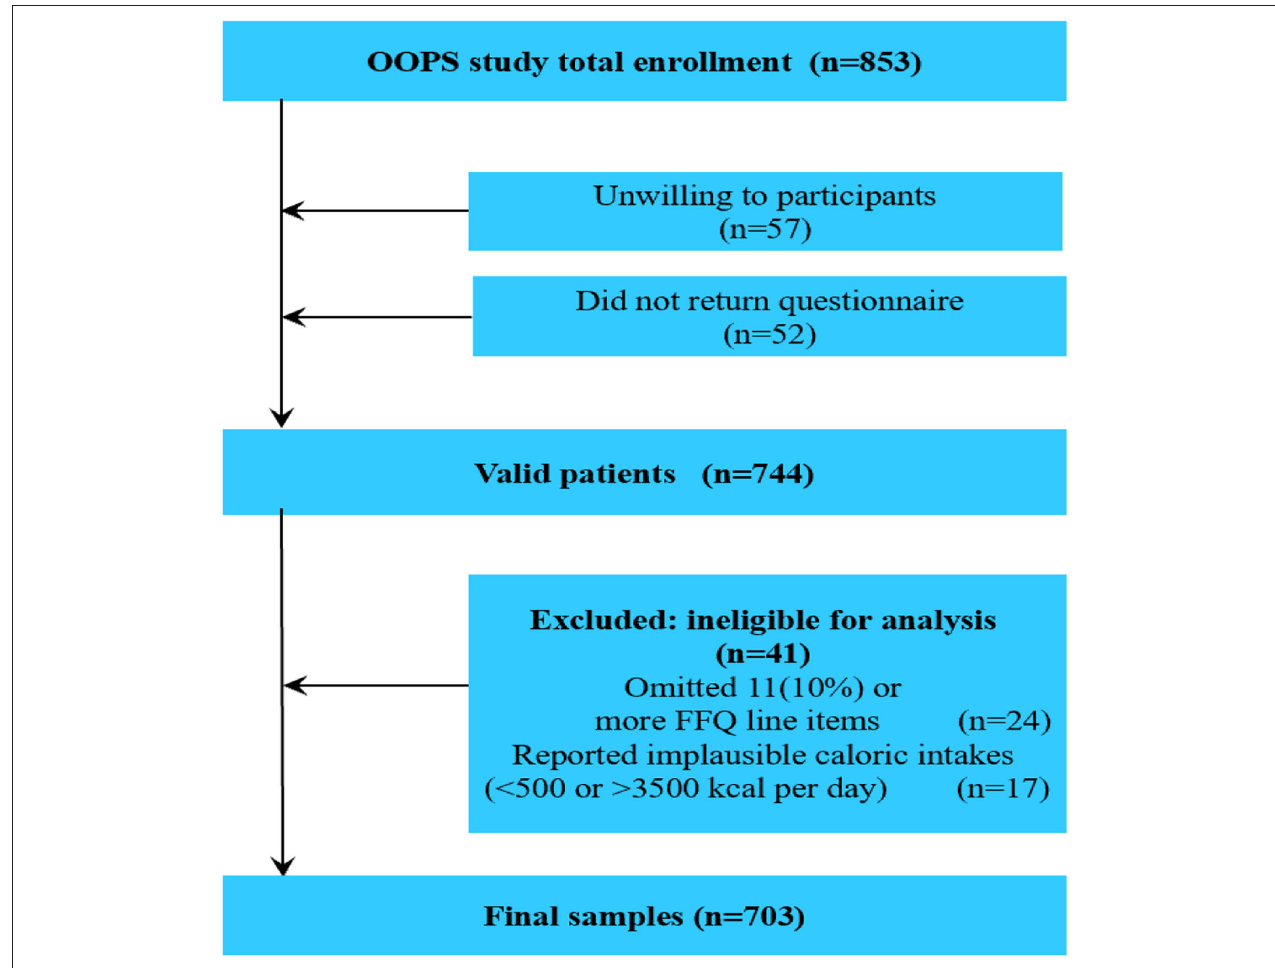
FIGURE 1 | Flow of participants through